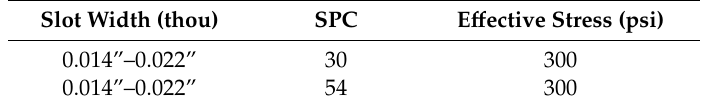
Table 1. Testing matrix to study the role of slot width at constant slot density. Table 2. Testing matrix to study the role of slot density at constant slot